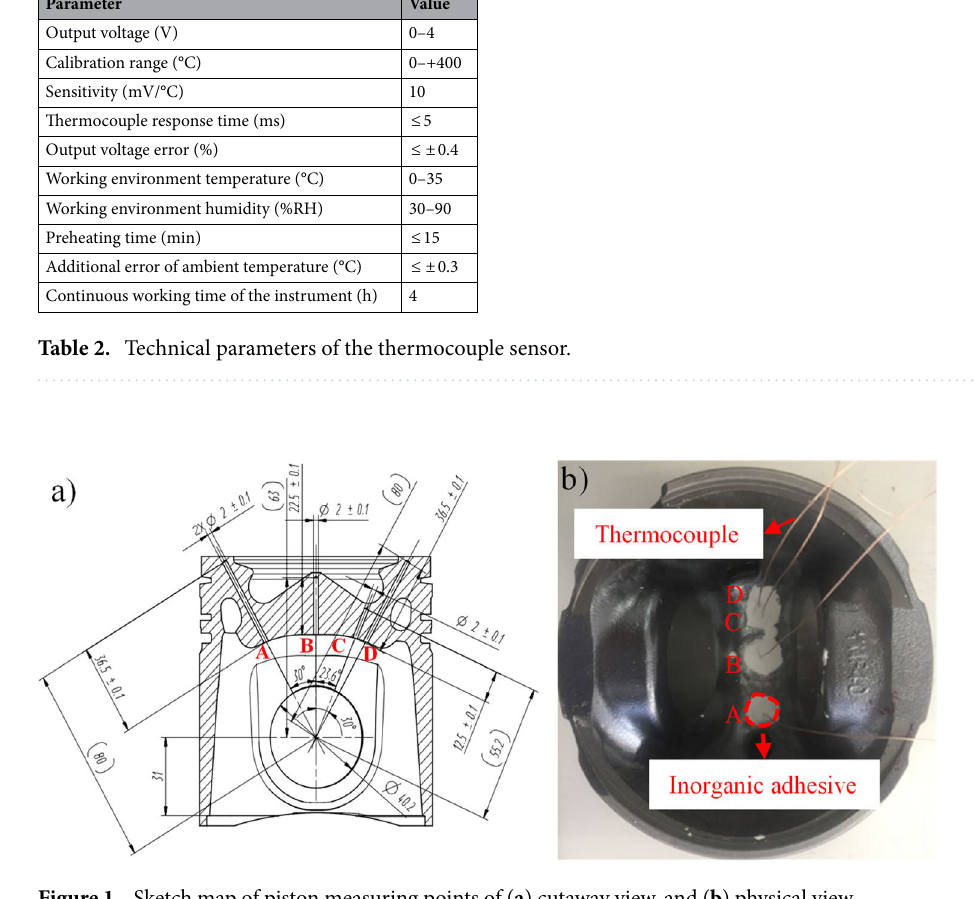
Figure 1. Sketch map of piston measuring points of ( a ) cutaway view, and ( b ) physical